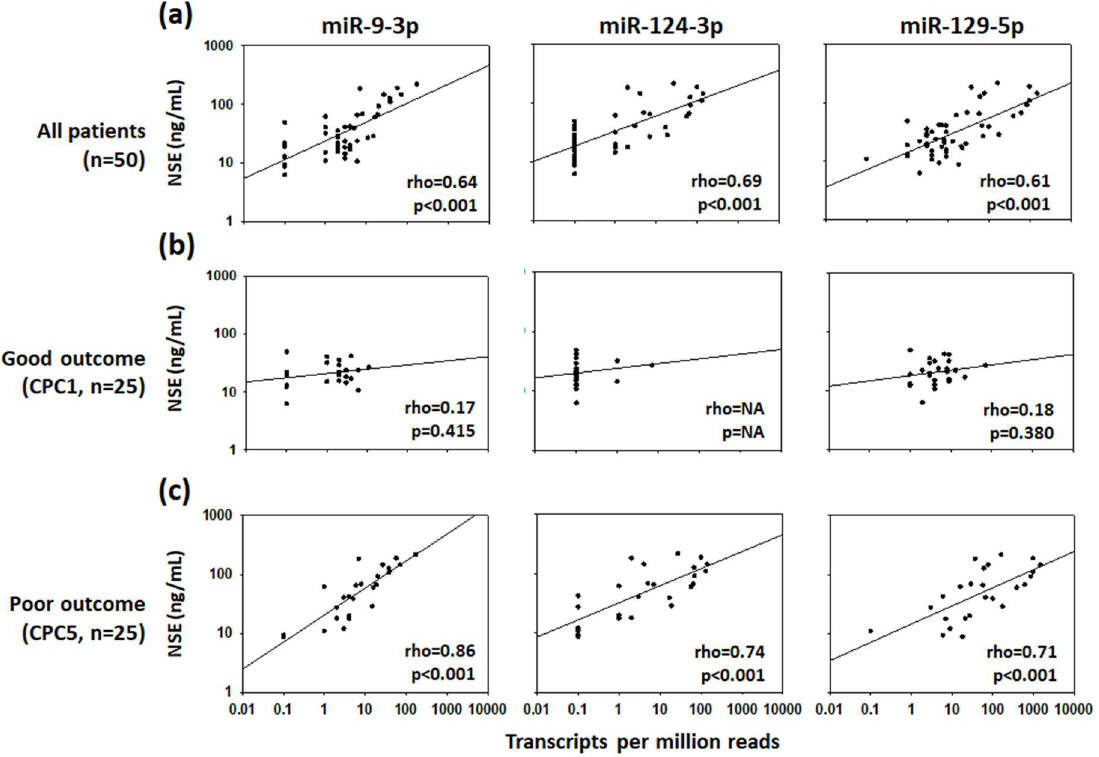
Figure 1. Correlations between miRNAs and neuron-specific enolase (NSE). Scatter plot and linear regression lines show the correlation between NSE and levels of miR9-3p, miR124-3p, and miR129-5p, ( a ) measured 48 h after ROSC in 50 patients, ( b ) 25 patients with good neurological outcome (CPC 1) and ( c ) 25 patients with poor neurological outcome or died (CPC 5) at 6 months after cardiac arrest. Spearman correlation coefficients (rho) and p -values are indicated. NA = Not applicable as only few patients have miRNA values above the level of detection.